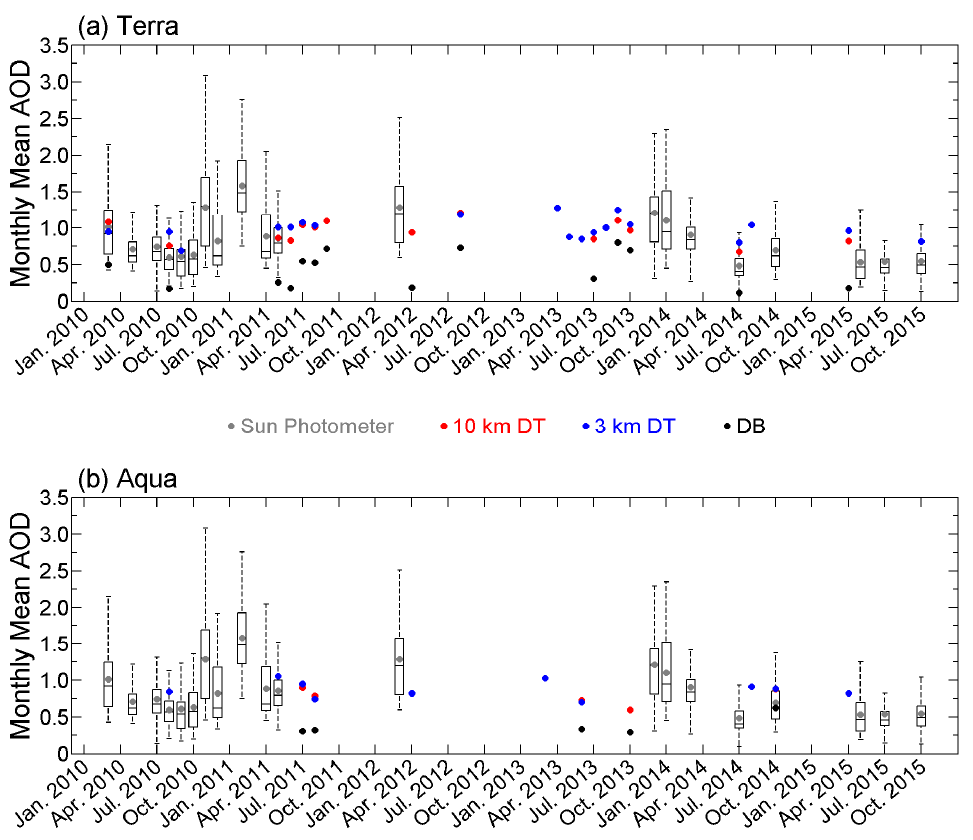
Figure 7. Time series of the monthly mean AODs of ( a ) Terra and ( b ) Aqua MODIS products with good quality and the sun photometer observations from 2010 to 2015. The gray, red, blue and black dots are the monthly mean of AODs from the sun photometer, 10 km DT, 3 km DT, and DB algorithms. In the box-whisker plots, the horizontal bars, upper and lower limits of the boxes are the medians, 25% and 75% percentiles. The whiskers are the minimum and maximum sun photometer AODs.